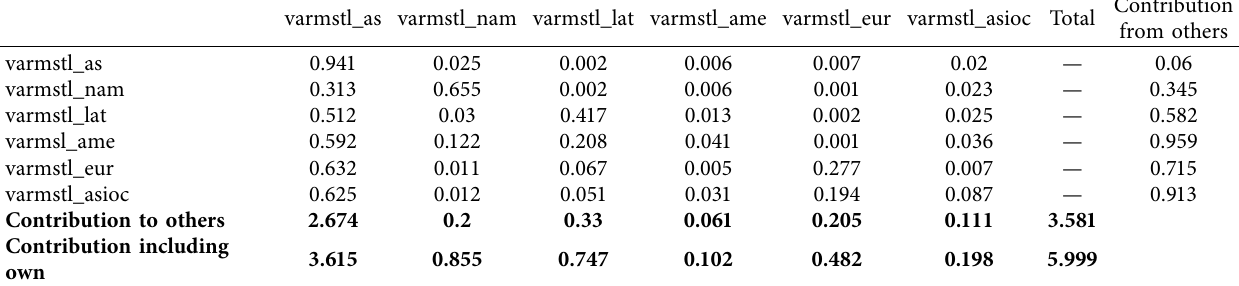
Panel B: 5-month-ahead forecast-error variance